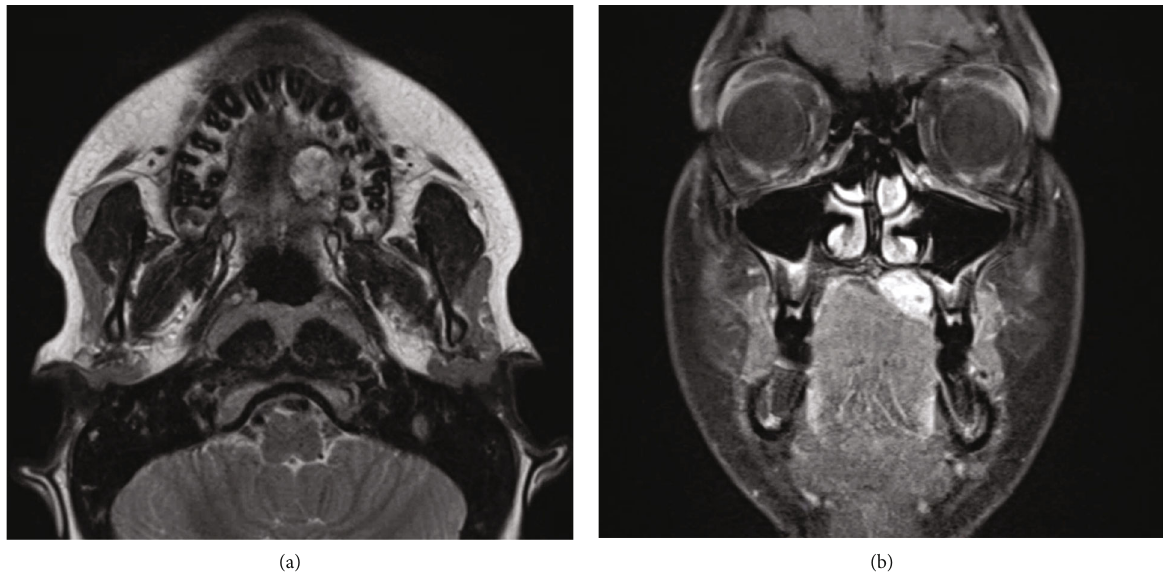
Figure 2: MRI sections showing a well-de fi ned, homogenous enhancing lesion in the left